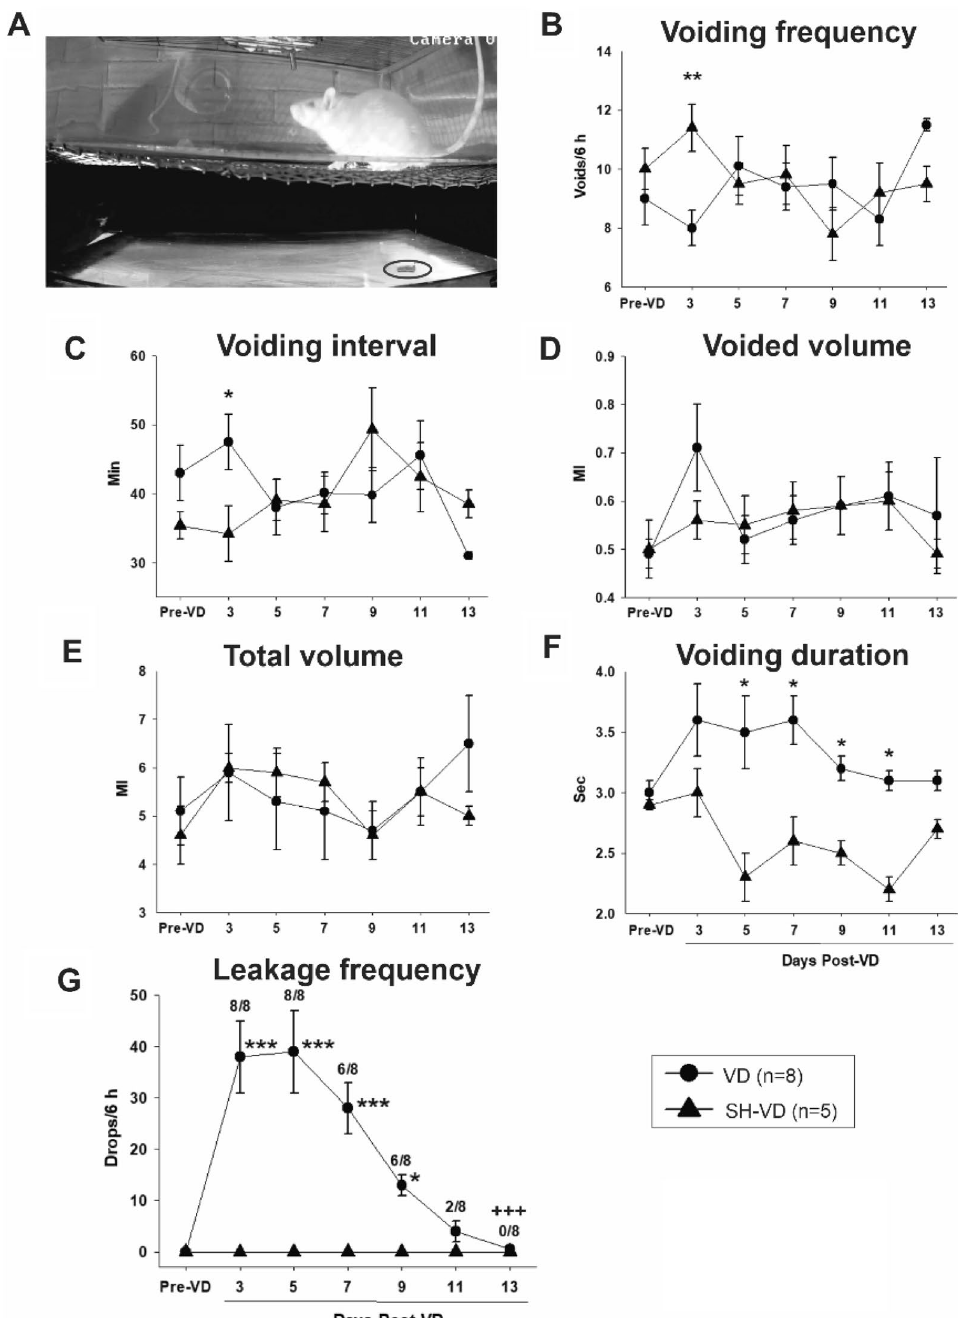
Figure 2. Micturition behavior and urinary parameters of female rats after vaginal distension (VD). ( A ) Photograph depicting stereotyped micturition behavior in the female rat (oval shape indicates urine expelled in the cage corner). Urinary parameters during the dark phase after VD or sham VD (SH-VD) including voiding frequency ( B ), voiding interval ( C ), voided volume ( D ), total voided volume ( E ), and voiding duration ( F ). ( G ) Number of drops in the dark phase after VD or SH-VD at the same time point. Values represent mean ± standard error of the mean. * ( p < 0.05) and ** ( p < 0.01) indicate significant differences for VD values vs. SH-VD. +++ ( p < 0.001) indicates significant differences between VD at day 13 vs VD at days 3–7. Two-way repeated measures